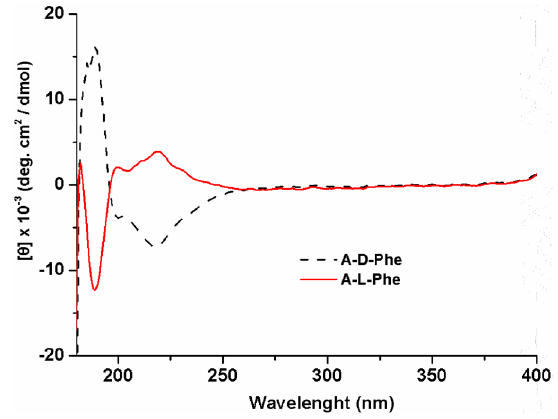
Figure 5. Circular dichroism spectra of monomers A-D-Phe (- - -) and A-L-Phe (——) in distilled water, in various conformations.